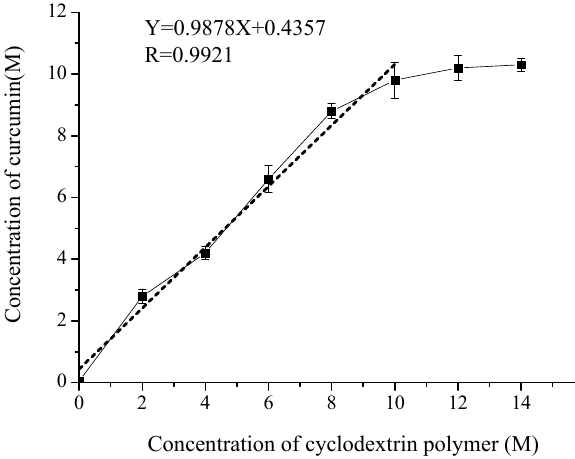
Figure 5. Phase solubility profile of curcumin/cyclodextrin polymer inclusion complex.